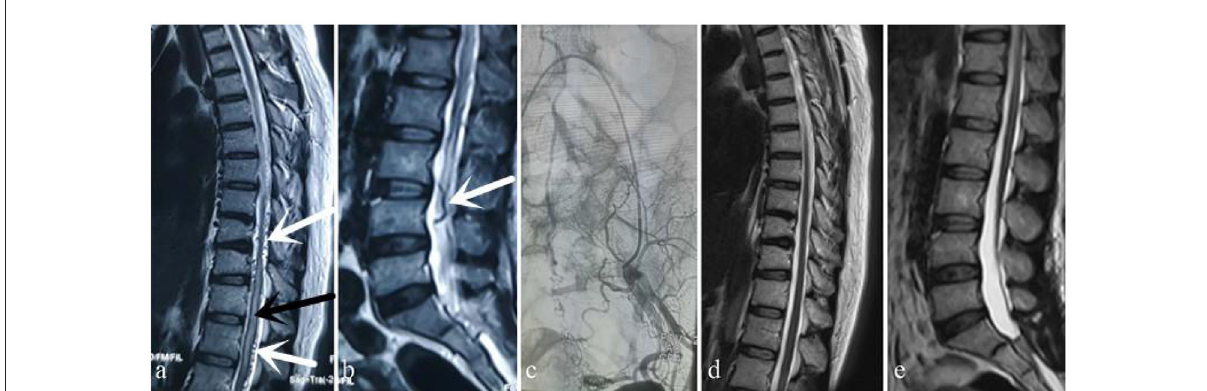
FIGURE1 Case 1. A 49-year-old woman sought treatment 7 months after the onset of initial clinical symptoms of numbness and weakness of the bilateral lower limbs with urinary disturbance. The patient was first evaluated at the orthopedics clinic. An orthopedic surgeon suspected a spinal DAVF based on thoracic and lumbar MRI, which showed thoracic spinal cord edema and beaded changes on the dorsal side (a) (white arrow: “beaded” dilated flow void signals, black arrow: spinal cord edema) and tortuosity and dilation of the lumbar dural surface vessels (b) (white arrow: tortuous flow void signals). After MDT consultation, angiography performed by a neurosurgeon showed that the fistula was located in the sacrococcygeal region (c) . MRI 6 months after surgery showed that spinal cord edema and signs of flow voids had subsided (d,e) .